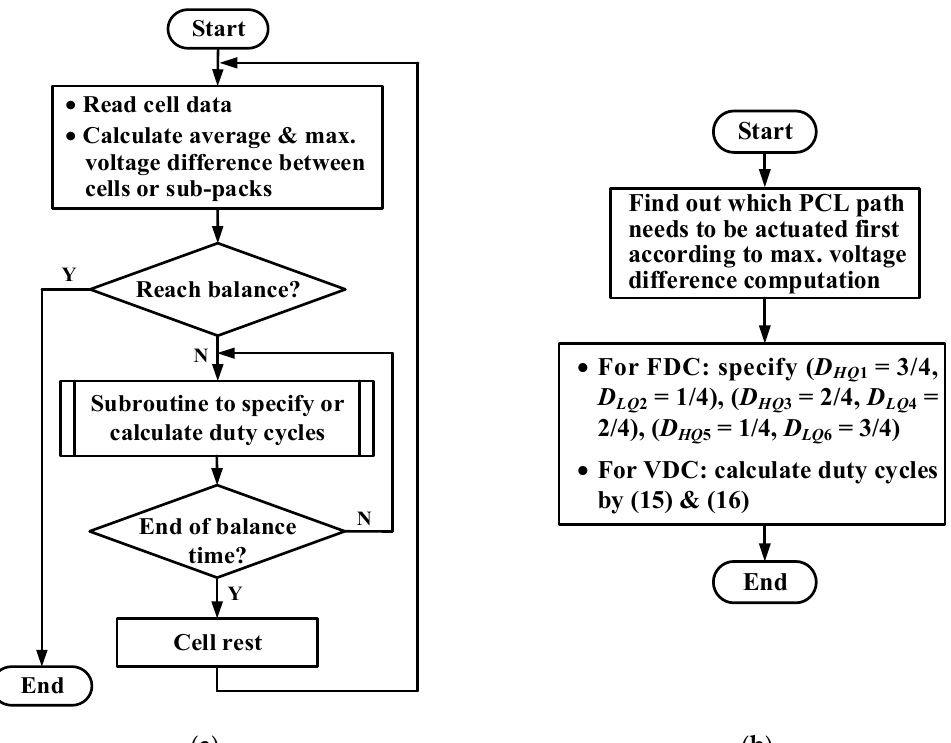
Figure 9. Operating flowchart of the balance strategy: ( a ) Main program, ( b ) subroutine to determine or calculate the duty cycle.